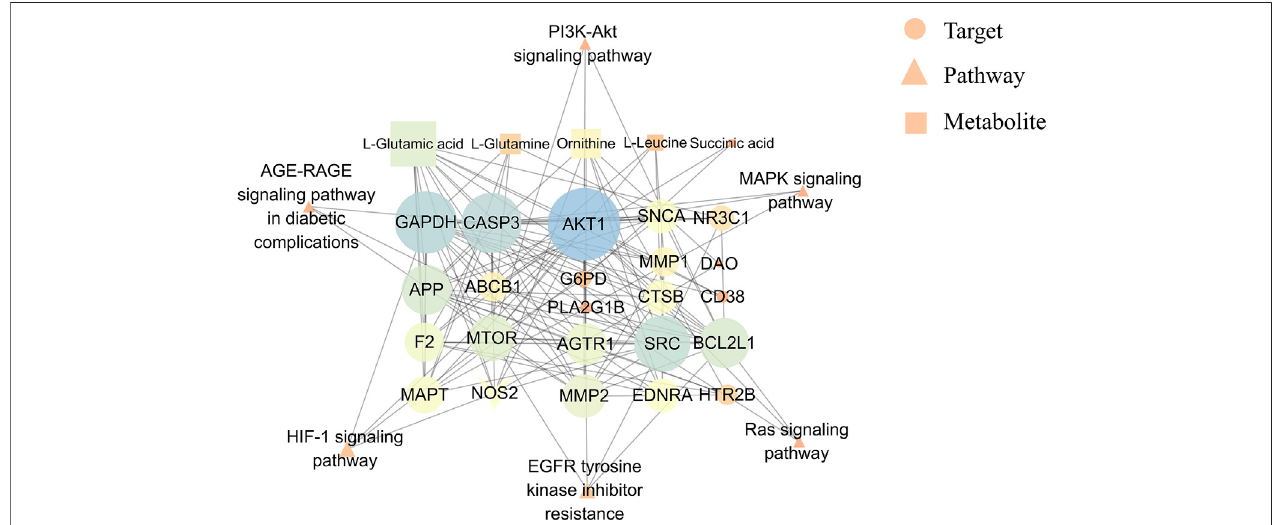
FIGURE 9 | Metabolites-targets-pathways